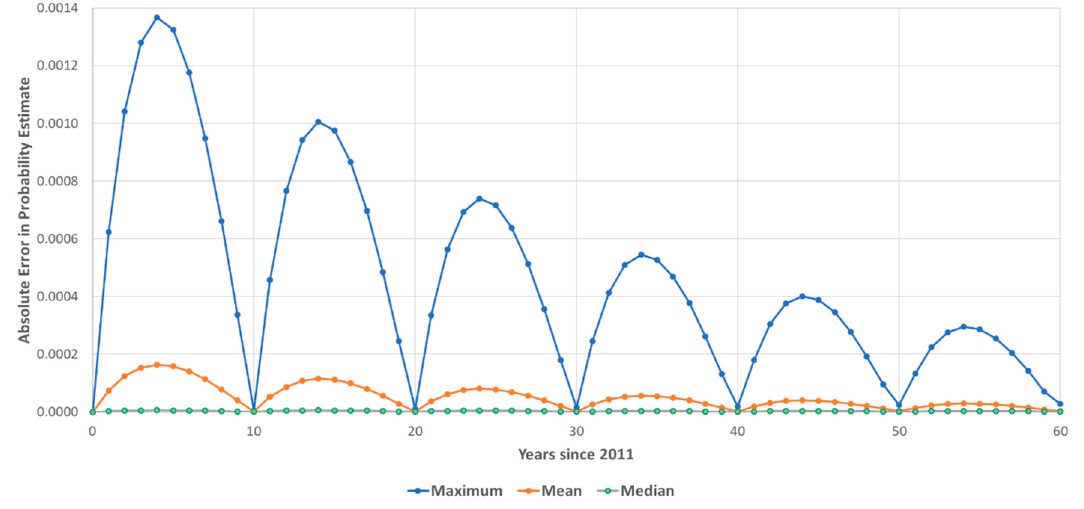
Figure 6. The error distribution in estimated transition probabilities over all 49 transitions for Florida from 2011 to 2071.